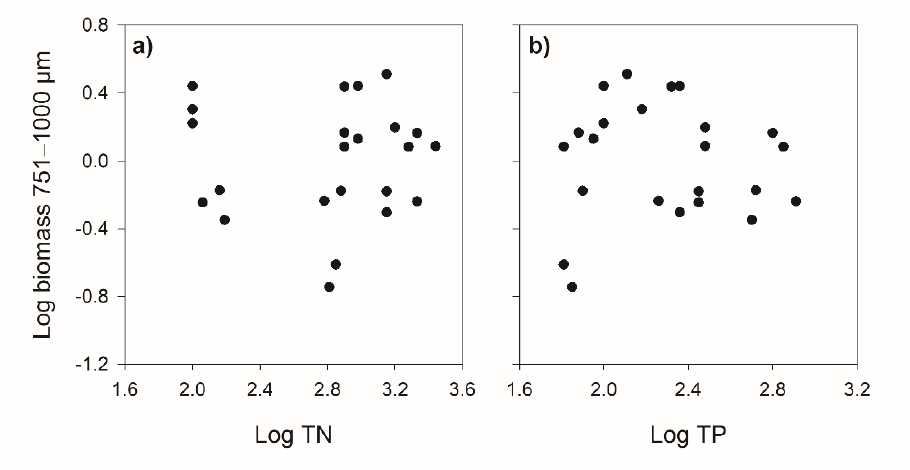
Figure 9. Multiple linear regression, displayed as scatter plots, between ( a ) total nitrogen (TN) and ( b ) total phosphorus (TP) and the biomass of the 751 – 1500 µm size fraction. In this size group, TN and TP concentrations were significantly correlated with the biomass.